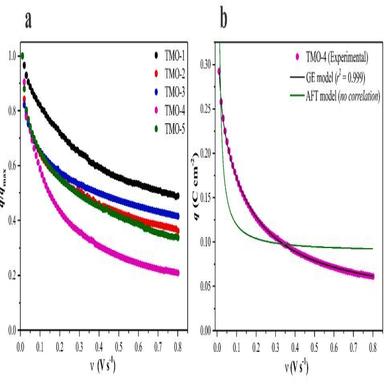
Experimental dependency of the normalized voltammetric charge (q/qmax) on the scan rate (a) for the different TMOs and the simulation data (b) obtained for TMO-4 using the GE (and AFT model. Electrolyte: 1.0 M H2SO4 (25 ◦C).